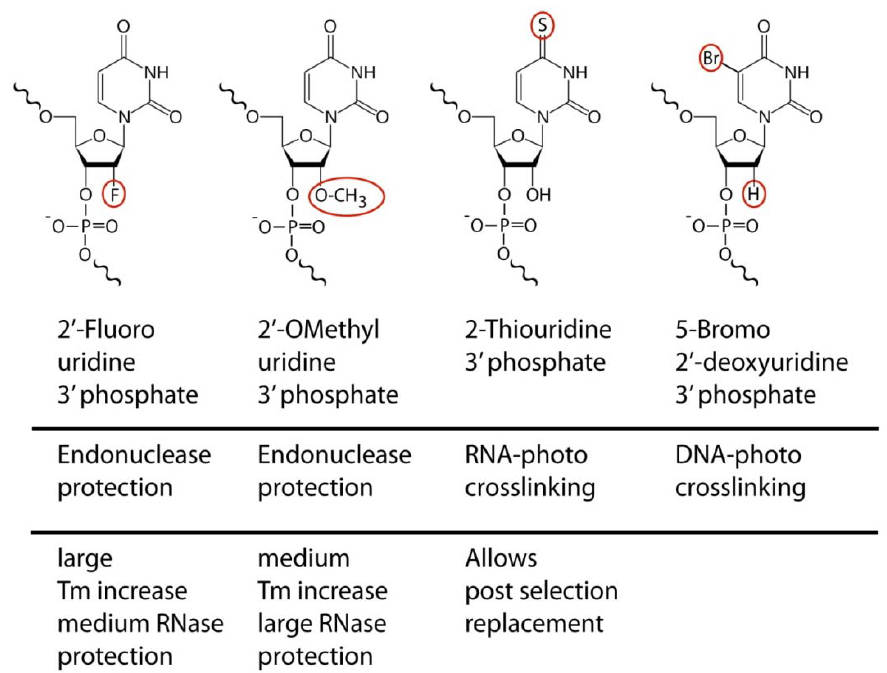
aptamers and that are with varying efficiencies compatible with enzymatic